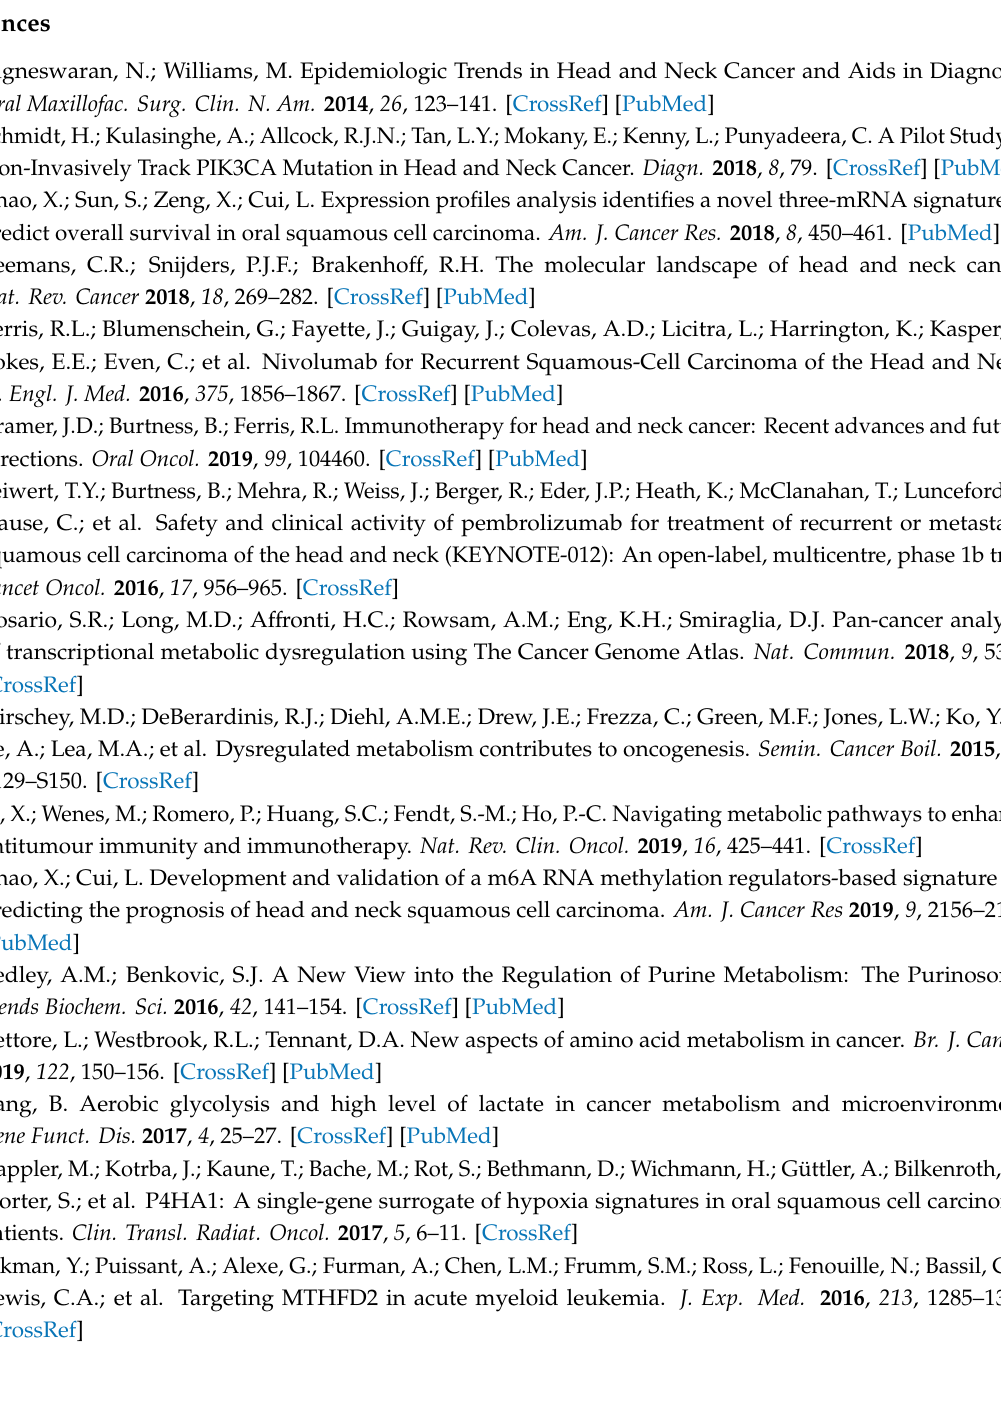
Table S1: The relative immune cell infiltration in HNSCC tumor samples; Table S2: The clinical information of the study cohort; Table S3: The significantly changed metabolic enzymes between HNSCC tumor tissues and the control tissues; Table S4: Identification of the immune-related metabolic enzymes in HNSCC; Table S5: The significantly di ff erentially expressed immune related metabolic enzymes in